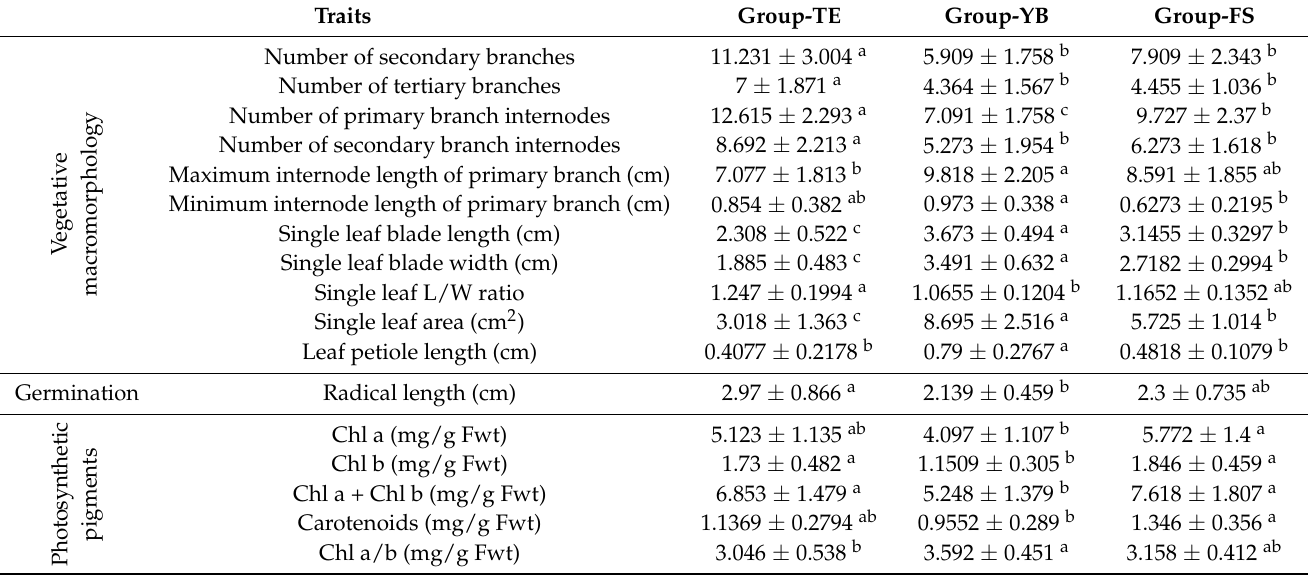
Table 2. One-way ANOVA results and pairwise comparisons among the three groups of Trianthema portulacastrum , showing the significant vegetative macromorphology, germination, and photosyn- thetic pigment traits. Groups that share same letters are non-significant, while different letters represent significantly different